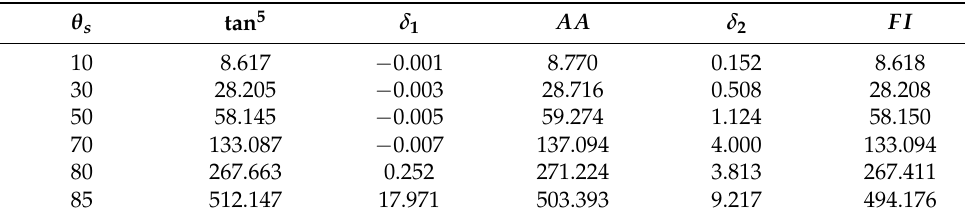
Table 1. Atmospheric refraction in arcseconds as a function of observed zenith angles for different approximations of the refraction integral ( FI ) at Calern Observatory. Results are based upon a standard atmosphere model for λ = 782.2 nm, T = 15 ◦ C, p = 875 hPa, RH = 50%, φ = 43 ◦ 45 (cid:48) 7 (cid:48)(cid:48) , and h = 1323 m, where λ represents wavelength, T is temperature, p is pressure, RH is relative humidity, ϕ is latitude and h is altitude. Data based upon Corbard et al. [41]. tan 5 represents the truncation of the expansion in the odd power-of-tangent refraction model that accounts for topographic, atmospheric and wavelength parameters, and AA represents the refraction formulation in United Kingdom Hydrographic Office [42] that only accounts for temperature and pressure. The parameters γ 1 and γ 2 represent tan 5 − FI and AA − FI , respectively.